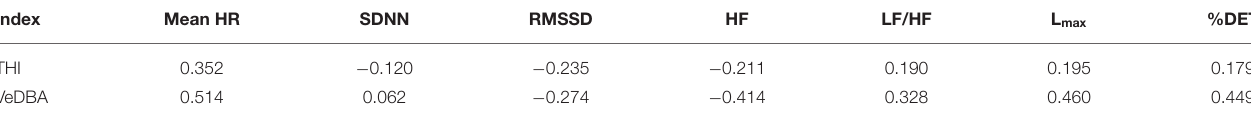
TABLE 4 | Pearson’s correlation coefficients of mean HR and HRV parameters with THI and